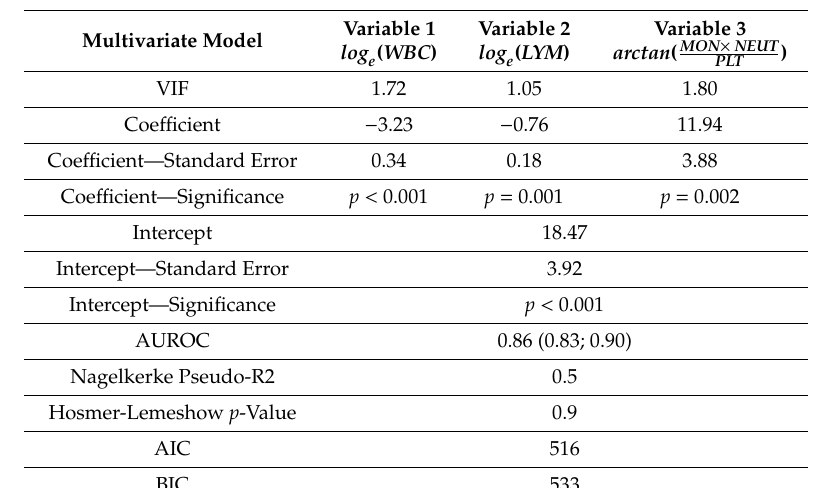
Figure 1. Univariate models probability plot. The vertical axis shows the probability of being SARS-CoV-2 positive according to each model. The horizontal axis shows the values of blood leukocytes (i.e., WBC, NEUT, LYM, and MON) and platelets, which are reported as leukocytes // platelets. Given the different amplitude of leukocytes and platelets blood concentration, their respective units of measure, as reported in the figure, should be multiplied by a factor of 10 3 (e.g., 1.5 leukocytes × 10 3 /mm 3 are equivalent to 1500 cells/mm 3 and 60 platelets × 10 3 /µL are equivalent to 60,000 cells/µL). WBC: white blood cell; NEUT: neutrophils; LYM: lymphocytes; MON: monocytes; EOS: eosinophils; PLT: platelets. Table 4. Multivariate Model Information. The multivariate model was built employing those variables that univariately showed an AUROC > 0.65 and a Hosmer – Lemeshow P -Value > 0.05. Variables were transformed employing natural logarithmic and arctangent functions. Globally, the model was shown to be more balanced in its discrimination and calibration metrics if compared to each of the univariate models.